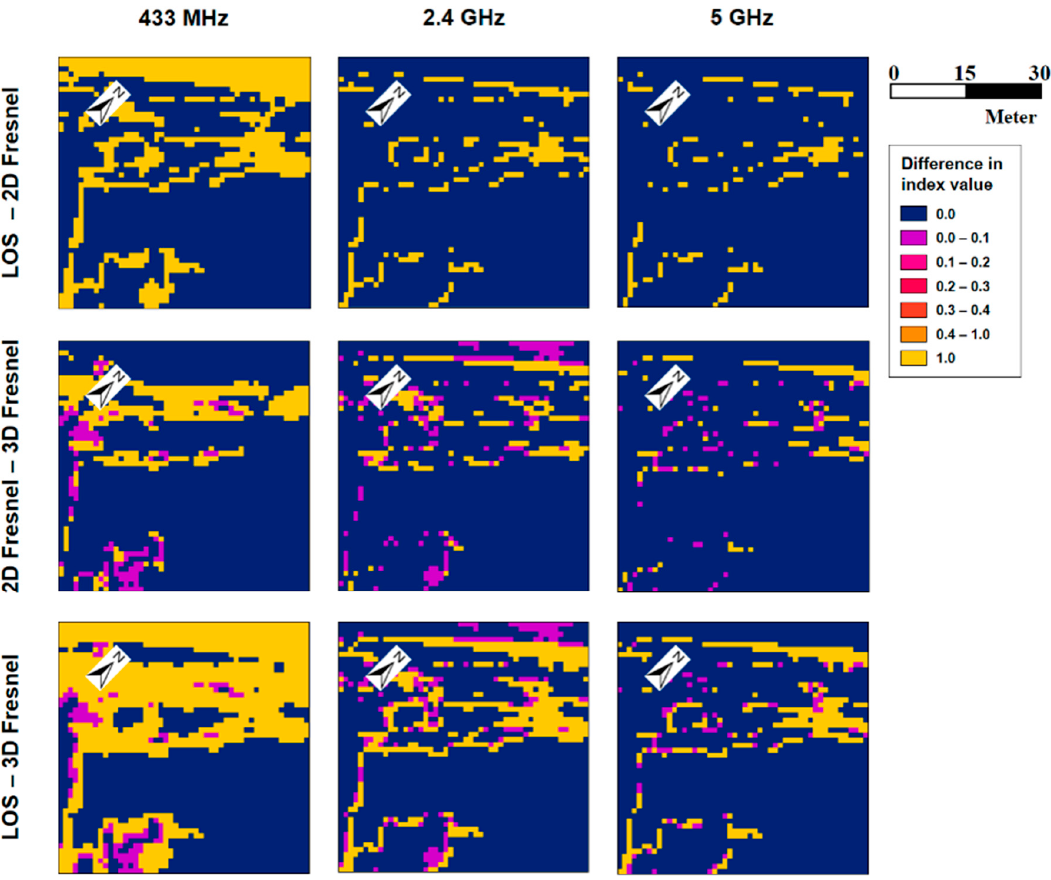
Figure 11. Differences between visibility index maps, 2D Fresnel index maps, and 3D Fresnel index maps for transmitter 1 at a frequency threshold of 433 MHz, 2.4 GHz, and 5 GHz.